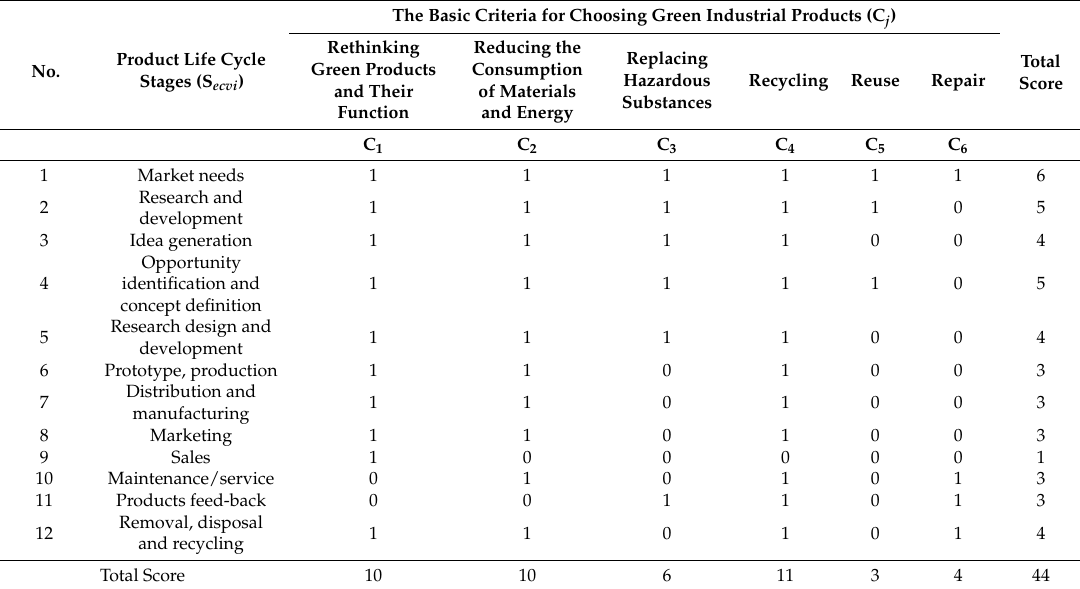
Table 2. Determination of green industrial performance of the “Tractor Truck 18.5